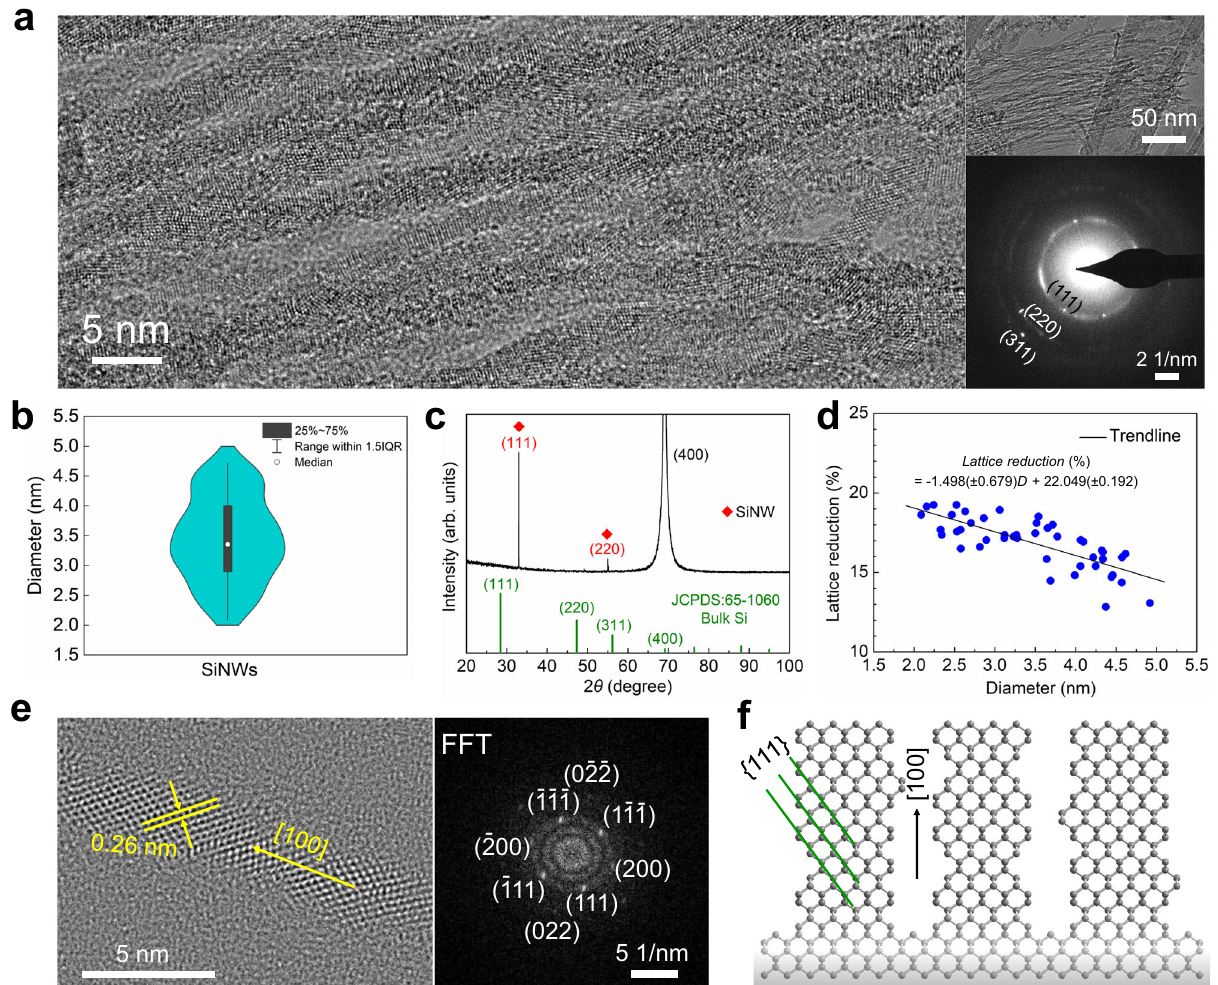
Fig. 2 Crystal structure analysis of the vertically aligned high-density SiNWs. a HRTEM images and SAED pattern of multiple crystalline SiNWs. b Violin plot showing diameter distribution as determined from HRTEM. c X-ray diffraction pattern of the vertically aligned SiNWs on (100) Si substrate. The strong (400) peak is from the (100) silicon wafer substrate. d The relationship between lattice reduction and the diameter of the SiNWs. e HRTEM and corresponding FFT images of an individual Si nanowire. f Schematic illustration of the crystal orientation of vertically aligned (100) SiNWs on (100) Si substrate observed from <110> direction with a relatively rough